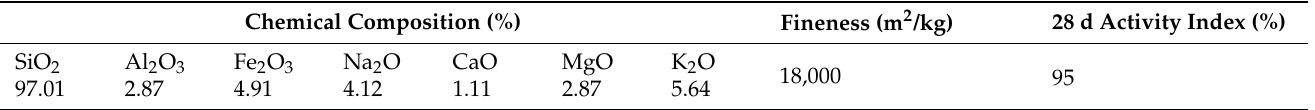
Table 3. Chemical composition and physical index of silica fume.